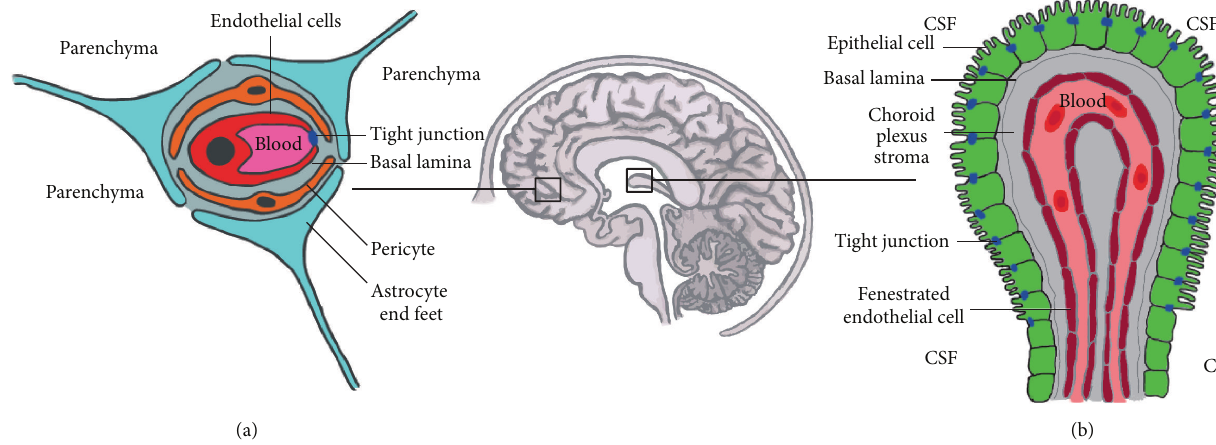
Figure 1: Barriers of the brain. (a) The BBB found between the lumen of the cerebral blood vessels and the brain parenchyma is composed of capillary endothelial cells, astrocytes, and pericytes and obtains its characteristic physical barrier function via linking the endothelial cells through luminal tight junctions. (b) The BCSFB located between the CSF and the fenestrated blood vessels of the choroid plexus. This selective barrier contains polar choroid plexus epithelial cells joined to one another through tight junctions found on the apical side.